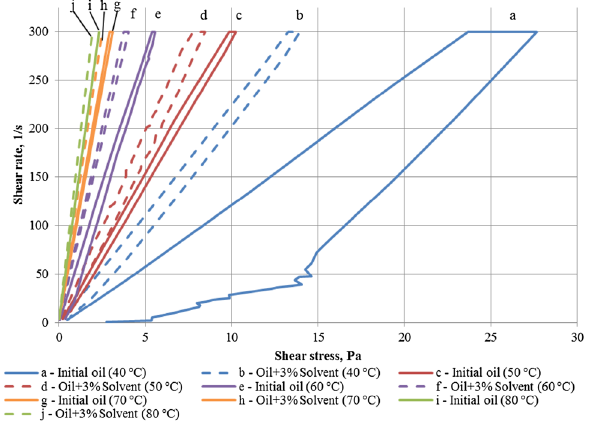
Fig. 8 Effect of shear rate on shear stress at different temperatures and solvent additions